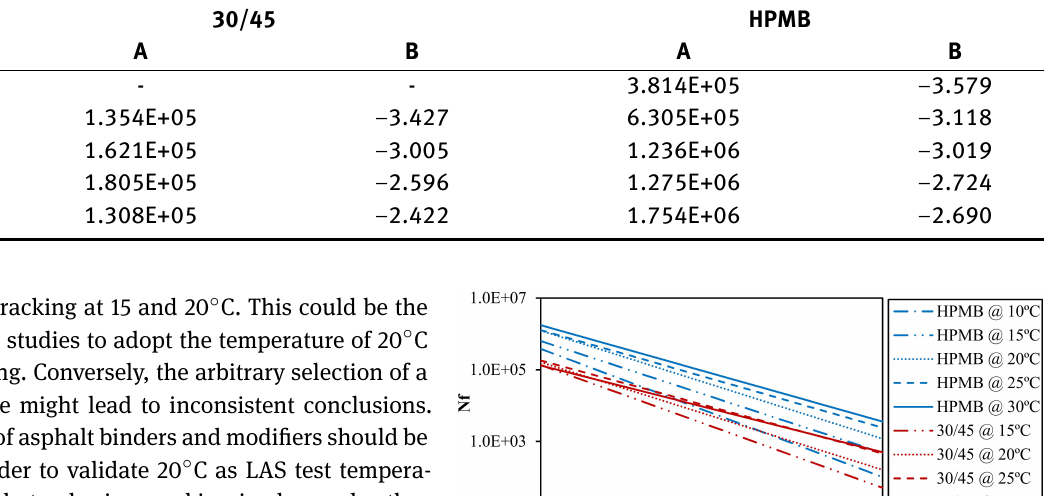
Table 6: LAS fatigue model parameters A and B Temperature